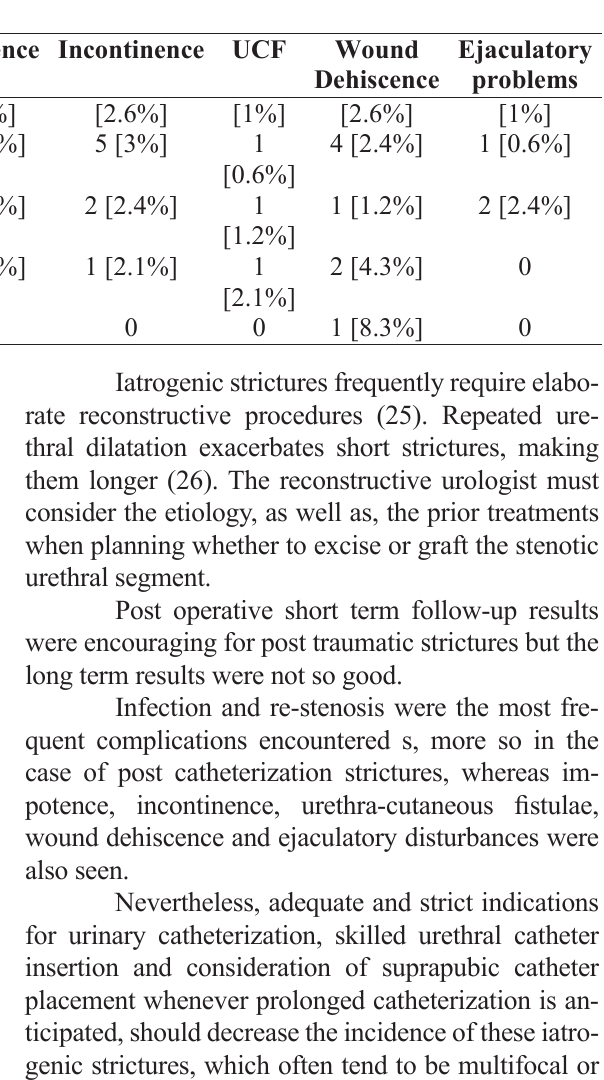
Table 4 - Complication rates based on stricture etiologies.